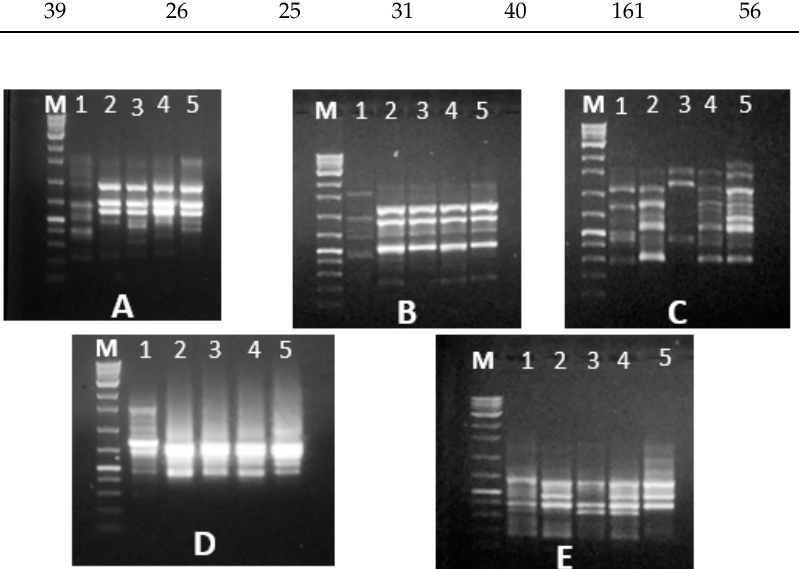
Table 4. Specific markers for R. ferrugineus populations across RAPD-PCR analysis.